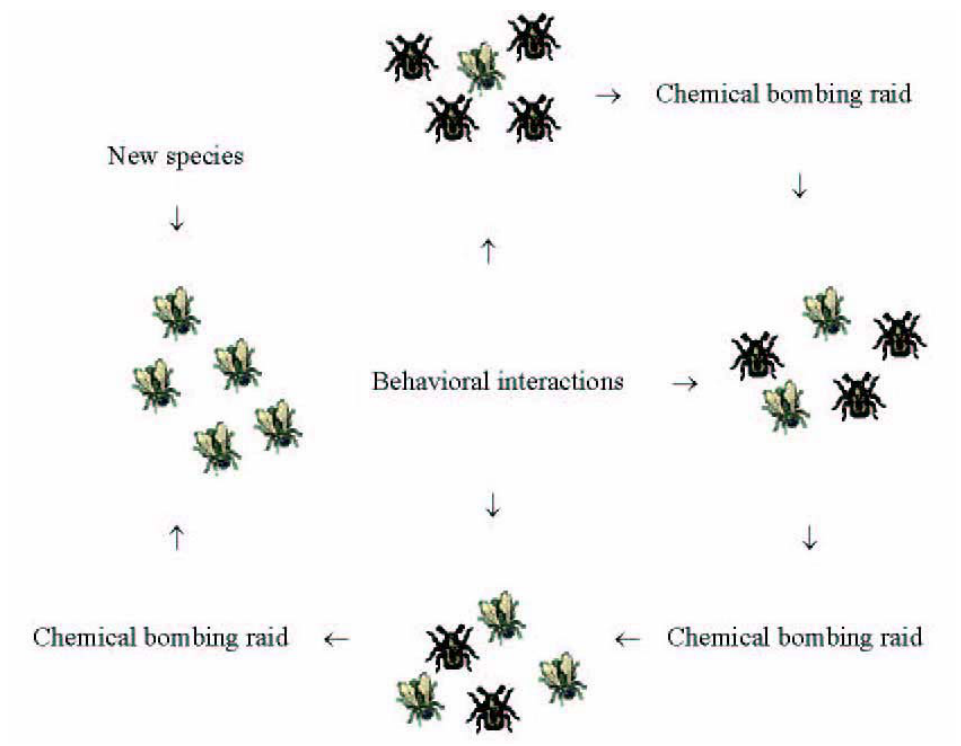
FIGURE 1. In a population, when there is a breeding ground for the development of a specific trait, e.g., the development of wings, this will gain behavioral patterns that favor the development of wings in the population through activation of biochemical reactions. At the same time, chemical substances are transferred between the individuals, also initiating biochemical reactions. Such biochemical reactions ensure the control over the genetic regime, so more and more individuals develop the wings. The more individuals that have the wings, the greater evolutionary pressure there is in the population in favor for wing development. In the end, this will involve the creation of a new